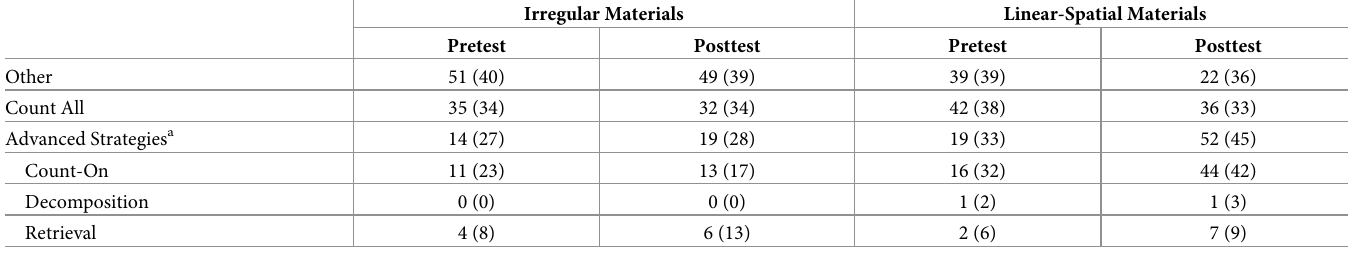
Table 2. Pretest to posttest change in strategy choice for children in the irregular and linear-spatial conditions. Shown is the percent of problems (SD) on which each strategy was